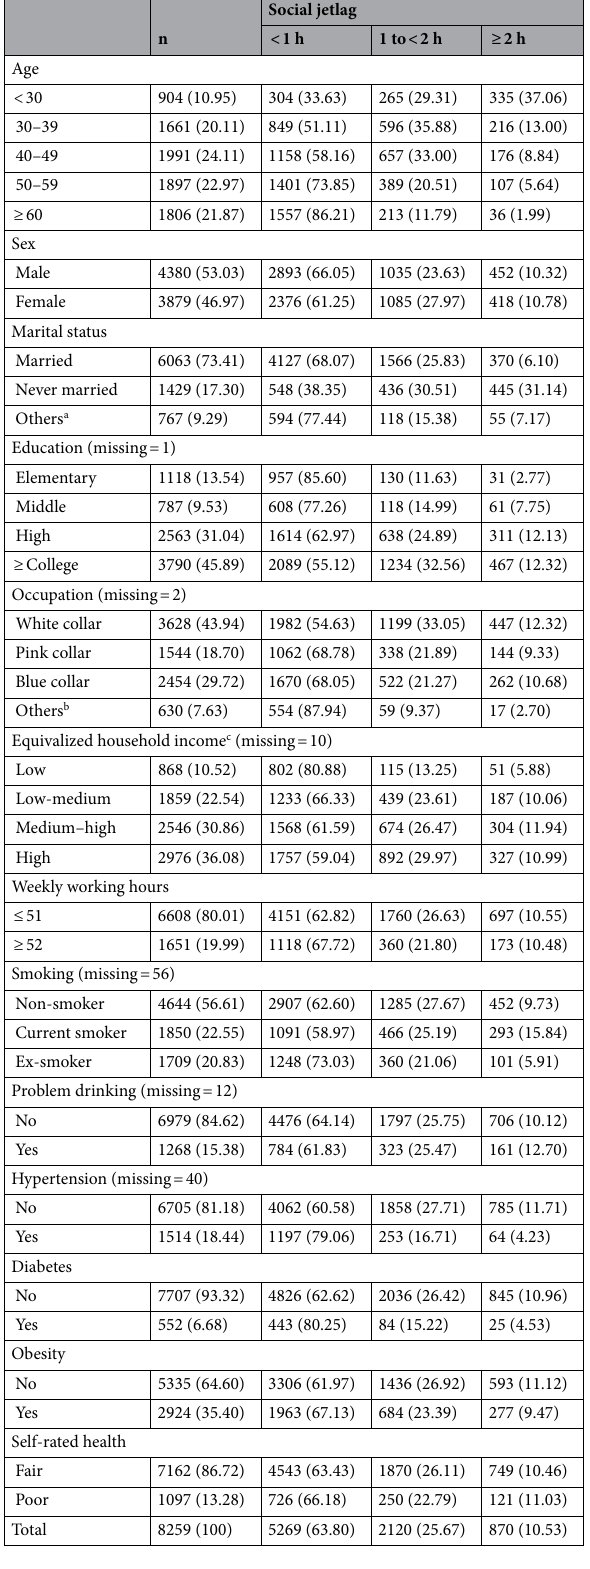
Table 1. Participant characteristics stratified according to the categories of social jetlag. a Widowed, separated, or divorced. b Workers in agriculture, forestry, fishery and military service. c Gross household income was divided by square root of household